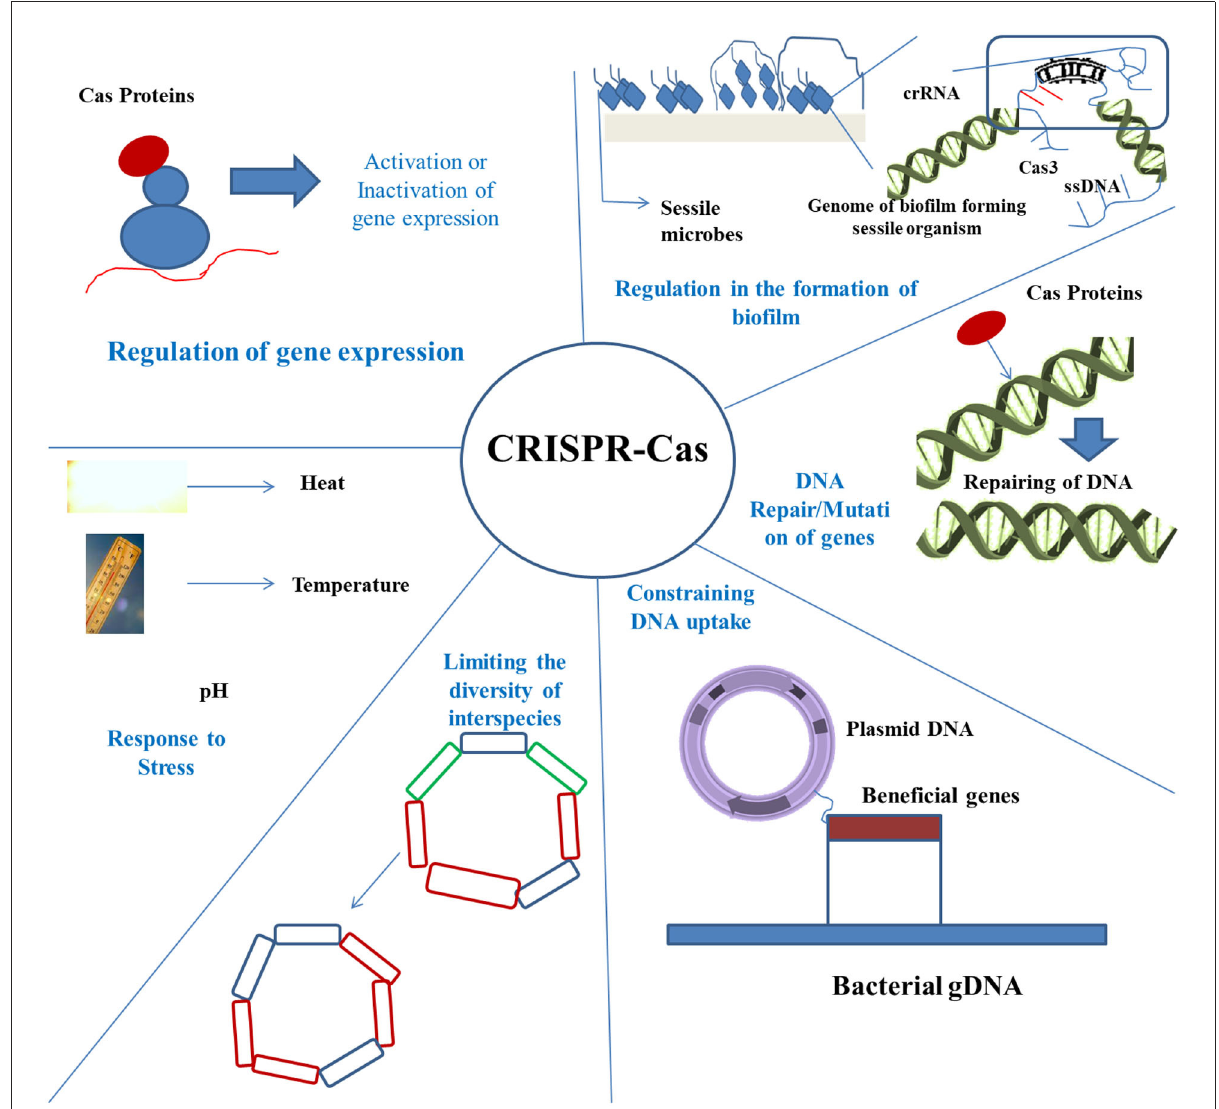
FIGURE2 Application of CRISPR-Cas in strategies to control biofilm. There are various mechanisms rendered by the CRISPR-Cas technique, including regulation of the biofilm formation, repair of DNA, preventing the uptake of DNA, bringing about limitation in species diversity, and controlling under various stress